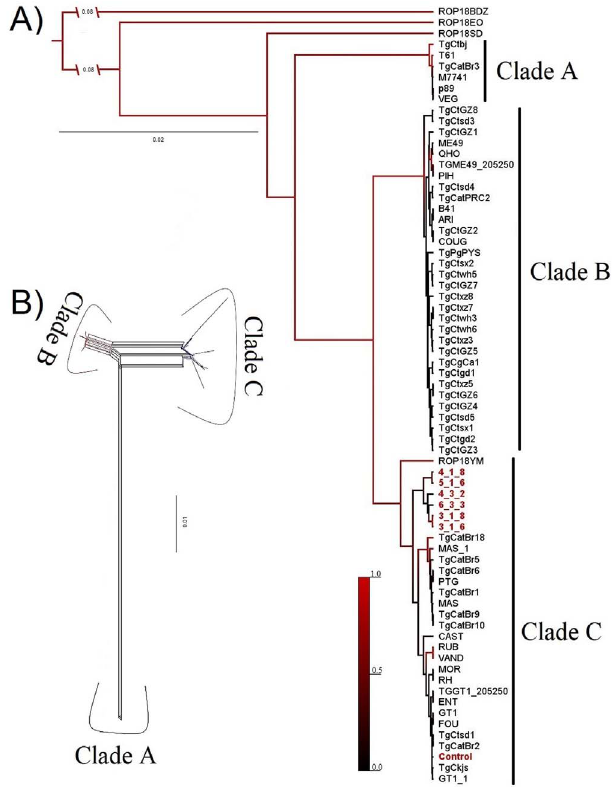
Figure 1. (A) Phylogenetic relationships among ROP18 sequences from several strains of T. gondii as reported in GenBank, and sequences found in cats in Armenia in present study are shown with numbers (6_3_3; 5_1_6; 3_1_6; 3_1_8; 4_3_2; 4_1_8) and in red font. The phylogeny was inferred by Bayesian analysis in BEAST. Branch lengths indicate genetic distance, and posterior probabilities of nodes are represented by the size of the branches that separate from the node. Major clades labeled are supported by absolute support (PP < 0.99). (B) Neighbor-net phylogenetic network based on the rhoptry protein 18 gene from T. gondii strains. Potential reticulation between strains is denoted by the network patterns connecting strains.